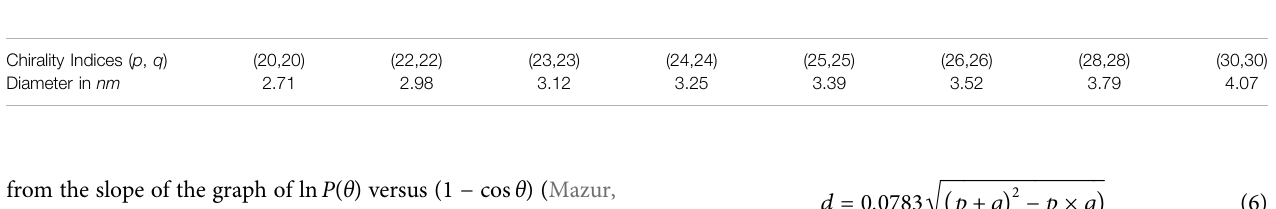
TABLE 1 | Diameters corresponding to different chirality indices of